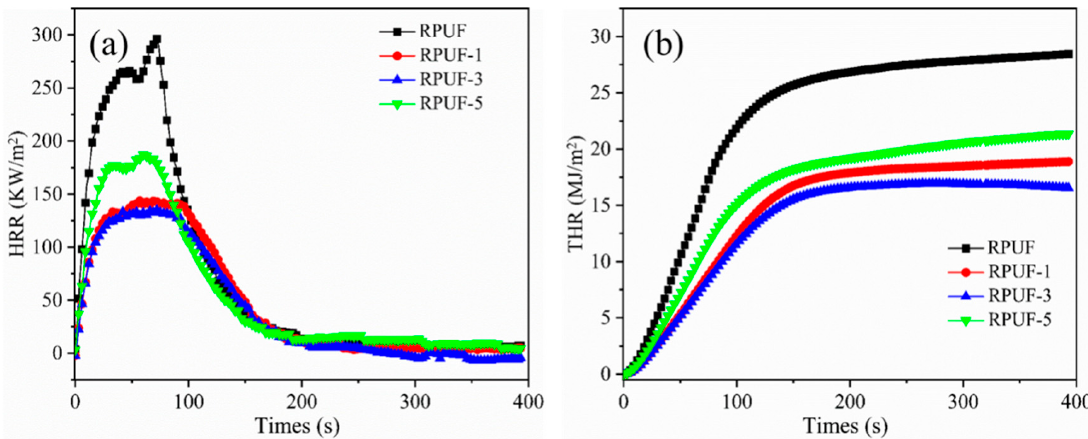
Figure 3. ( a ) HRR and ( b ) THRcurves of RPUF and RPUF-R composites.